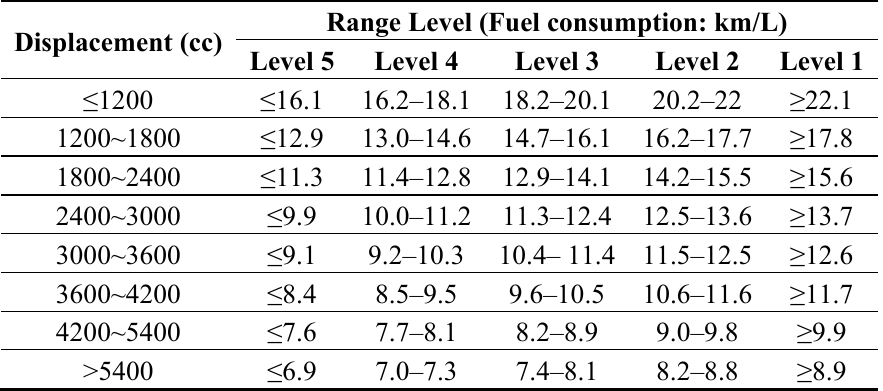
Table 2. The tested values of fuel consumption (USA Standard: FTP-75). Source